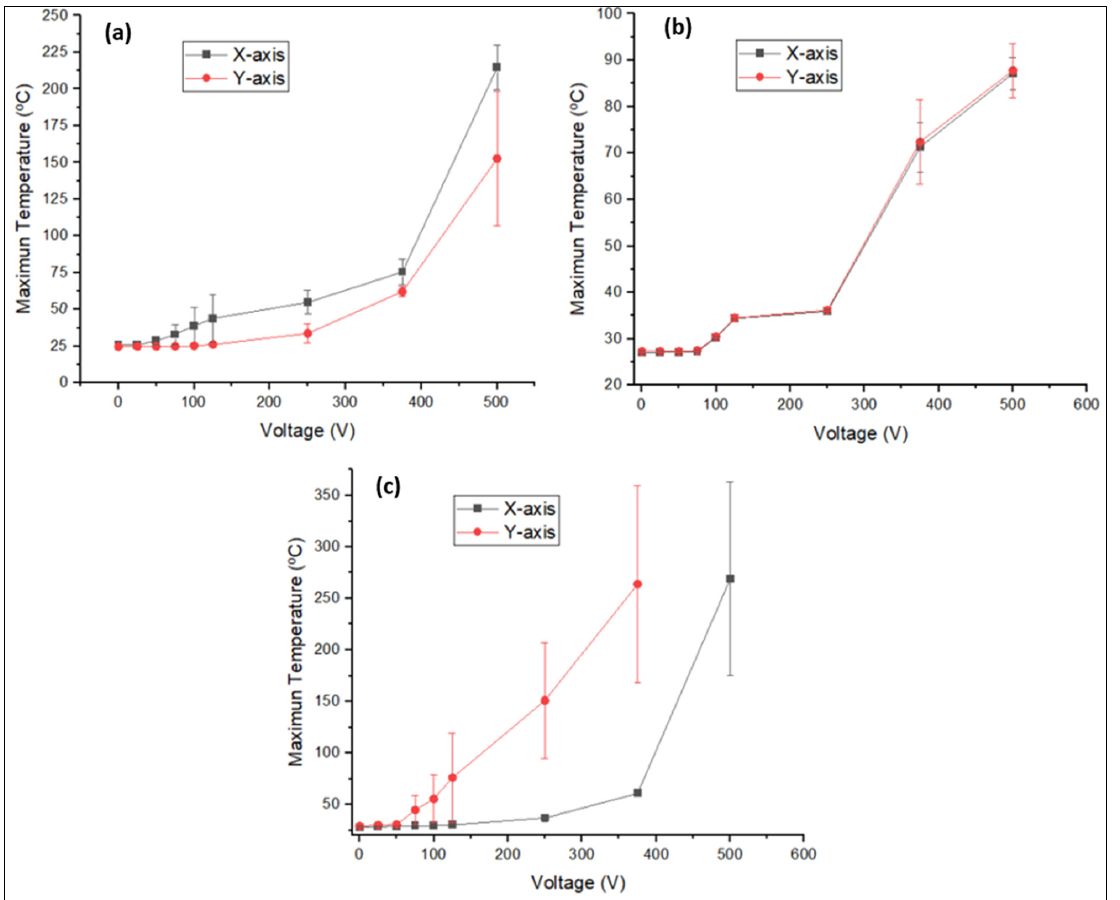
Figure 10. Heating results of the GNP/epoxy composites according to the type of graphene used and direction of bias imposition. Joule effect graph is plotted for the C300 30 min system ( a ), the C500 30 min system ( b ), and for the C750 30 min system ( c ).